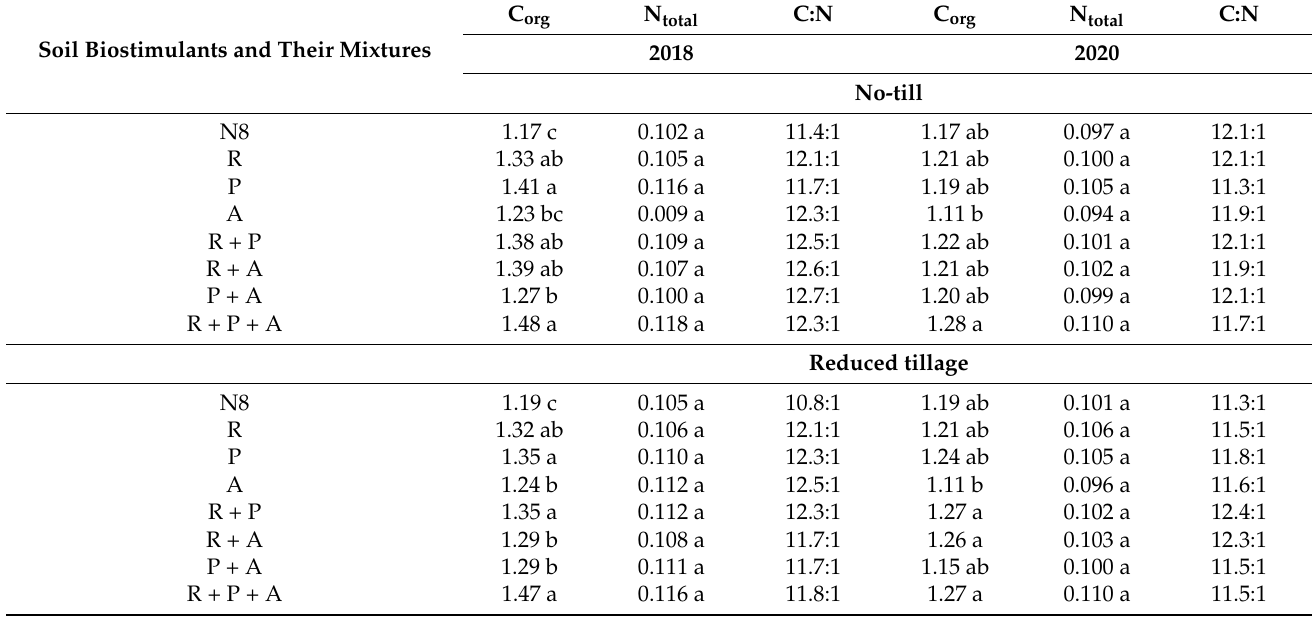
N8—compensatory nitrogen at 8 kg per ton of straw, without biological preparations; R— Ruinex 1 l ha − 1 ; P— Penergetic k 0.2 l ha − 1 ; A— Azofix 1 l ha − 1 ; R + P— Ruinex 1 l ha − 1 + Penergetic k 0.2 l ha − 1 ; R + A— Ruinex 1 l ha −